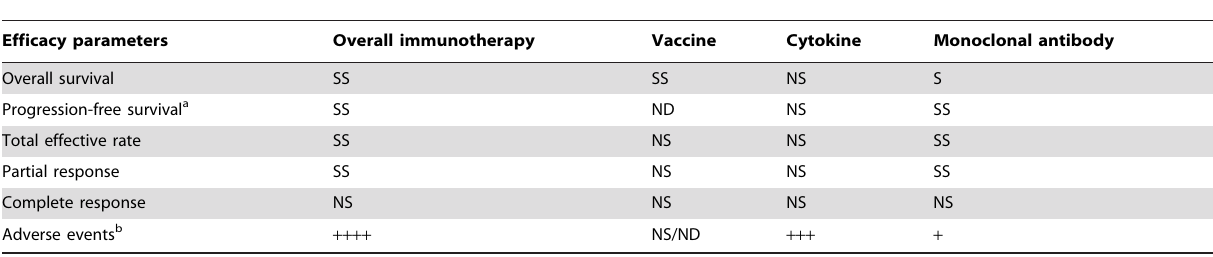
Table 7. Efficacy analysis on overall immunotherapy and